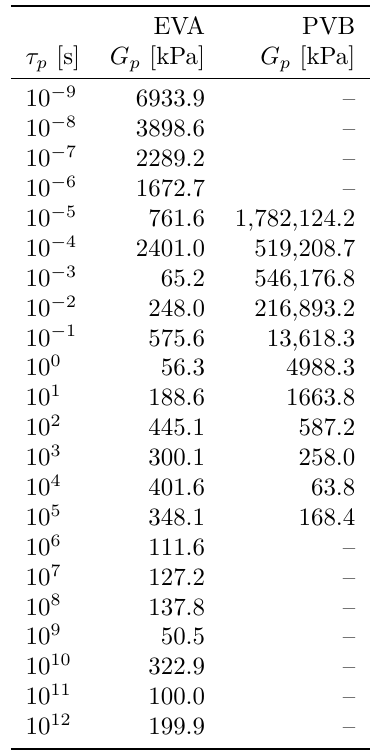
Table 1. Prony series for generalised Maxwell model complemented with the long-term moduli G ∞ = 682 . 18 kPa for EVALAM 80-120 (EVA-based foil) and G ∞ = 232 . 26 kPa for TROSIFOL BG R20 (PVB- based foil) for T 0 = 20 ◦ C from [3].